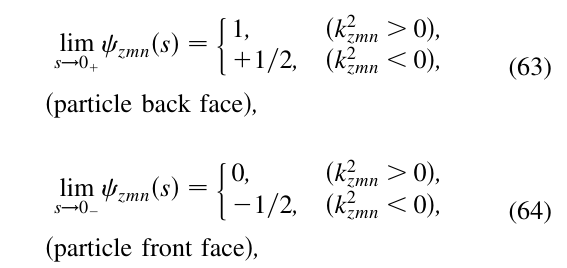
FIG. 9. (Color) Dependence of axial electric field E distance z for propagating (real) and decaying (imaginary) modes excited by a 1-nC, 0.5-MeV point bunch in a LSM 11 two-zone DLW structure with a height of 2 d (cid:4) 40 mm , where the first zone ( 0 < x < 2 mm ) is a vacuum channel and the second zone ( 2 mm < x < 5 mm ) is a dielectric slab with " (cid:4) 1 . The bunch is located at the center of the 5 : 7 and (cid:1) r 2 vacuum channel ( x (cid:4) 1 mm and y (cid:4) 0 ), and z (cid:4) 100 cm ; the axial fields are plotted on the line which the bunch lies on. It is seen that the decaying mode is highly localized compared to the propagating mode that has a frequency of 4.4 GHz. Note the different scales for propagating and decay